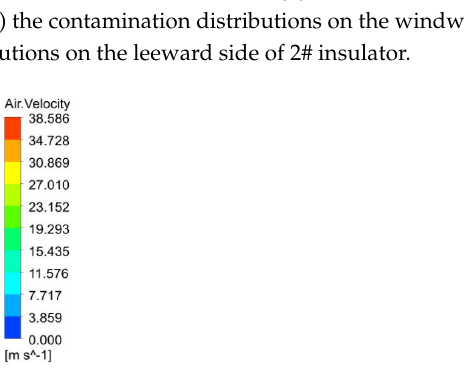
Figure 34. Cloud map of velocity distribution in the plane with 0 ◦ wind elevation angle.